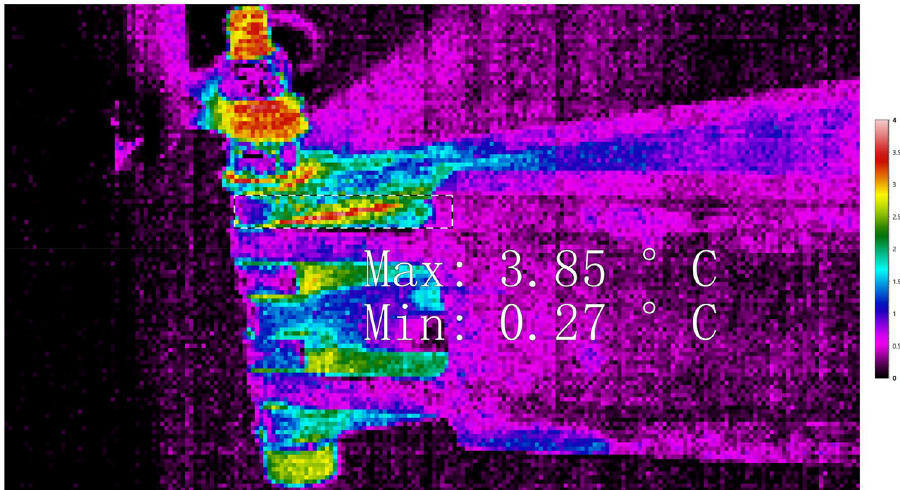
Fig. 19 The box created around the topmost interface to measure the maximum temperature